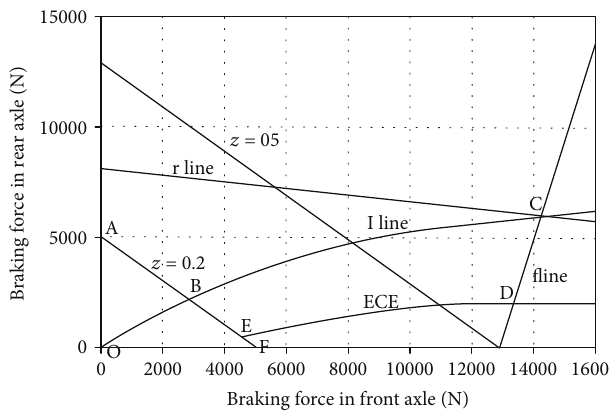
Figure 2: Brake safety